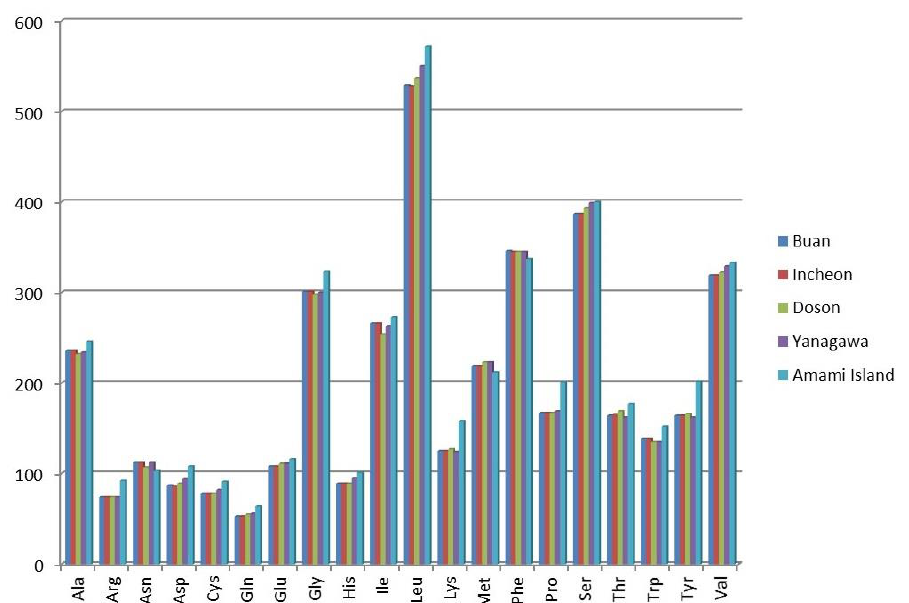
Figure 2. Amino acids corresponding to the codons of protein-coding genes of the Lingula anatina specimens. The specimens represented with localities: Buan, Korea (MW528457), Incheon, Korea (KX774482), Doson, Vietnam (MH371361), Yanagawa, Japan (AB178773) and Amami Island, Japan (KP881498).